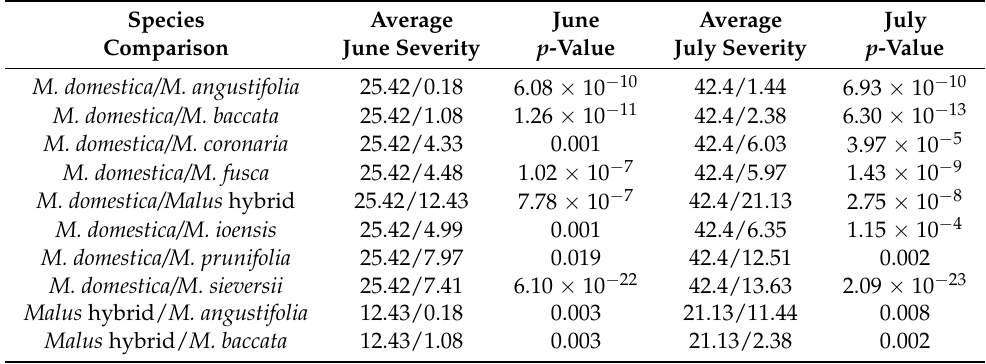
Figure 5. Main collection fire blight severity (%) in June ( left ) and July ( right ). The color and size of the circles indicates the number of trees. Only species with 10 or more trees are included in this figure. Table 1. Significant pairwise comparisons of fire blight severity in the main collection 667 tree subset in June and July for species with 10 or more trees. Comparisons are listed with the highest severity first.